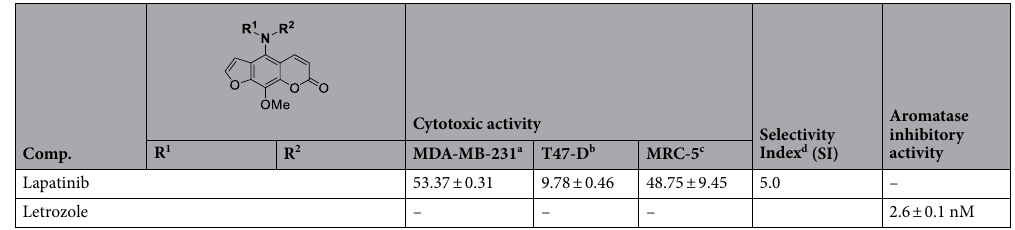
Table 1. Cytotoxic and aromatase inhibitory activities (IC 50 [µM]) of psoralen derivatives. Results are obtained from three independent biological repeats; a Hormone-independent breast cancer; b Hormone- dependent breast cancer; c Human embryonal lung fibroblast cell; d Selectivity Index (SI) = IC 50 for MRC-5/IC 50 for T47-D; e %Inhibition at the concentration of 50 mg mL −1 ; f %Inhibition at the concentration of 12.5 µM; I = %inhibition lower than 50% at a specified concentration; – not determined.